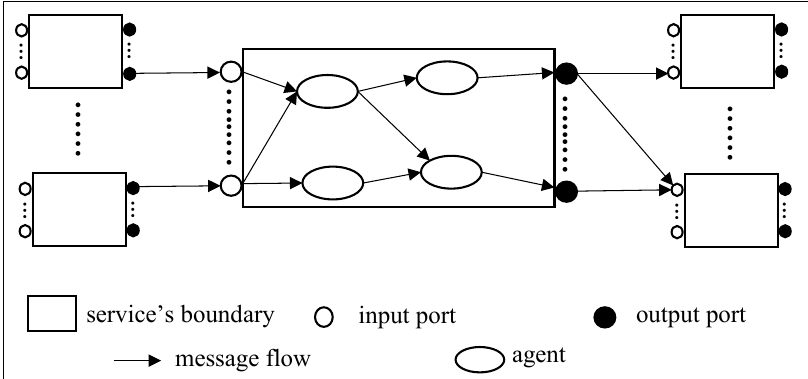
Figure 2. Communication between